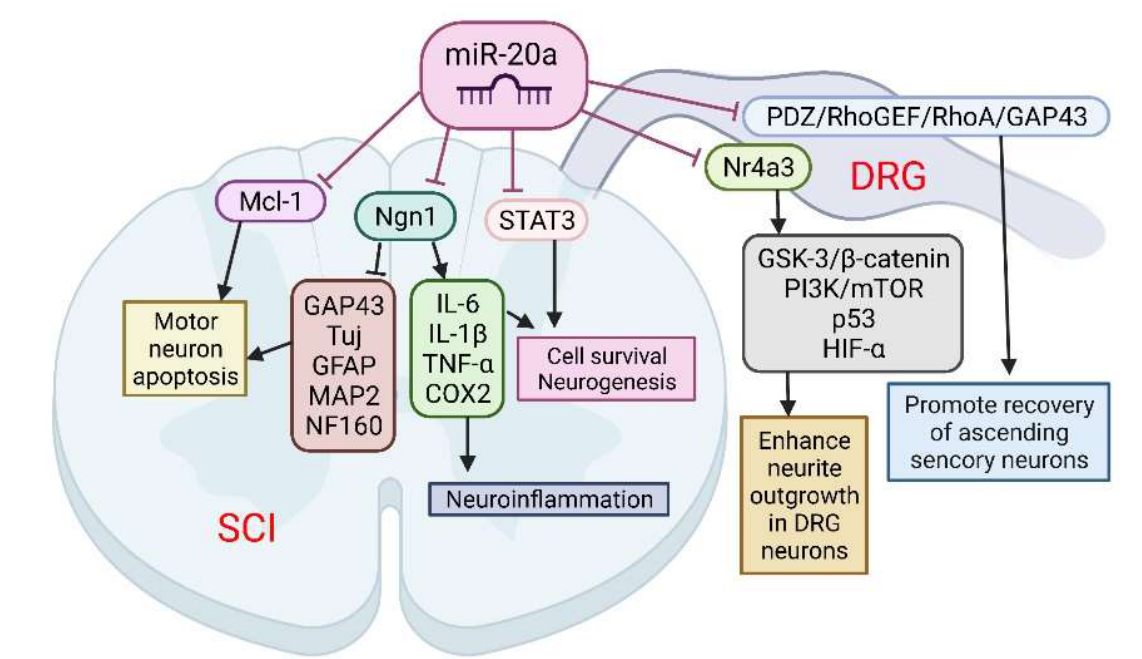
Figure 3. The role of miR-20a in spinal cord injury (SCI) and spinal cord dorsal lesions. SCI led to increased miR-20a expression and targeting of several proteins simultaneously: neurogenin 1 (Ngn1), Mcl-1, and STAT3. Suppression of these proteins has been implicated in several pathological events characteristic of the second phase of SCI: apoptosis of motor neurons, cell death, and neuroinflammation. On the other hand, miR-20a may increase neurite outgrowth in DRG neurons and promote recovery of ascending sensory neurons by interfering with Nr4a3 and PDZ–RhoGEF expression. This image was created using BioRender (accessed on 30 March 2022).